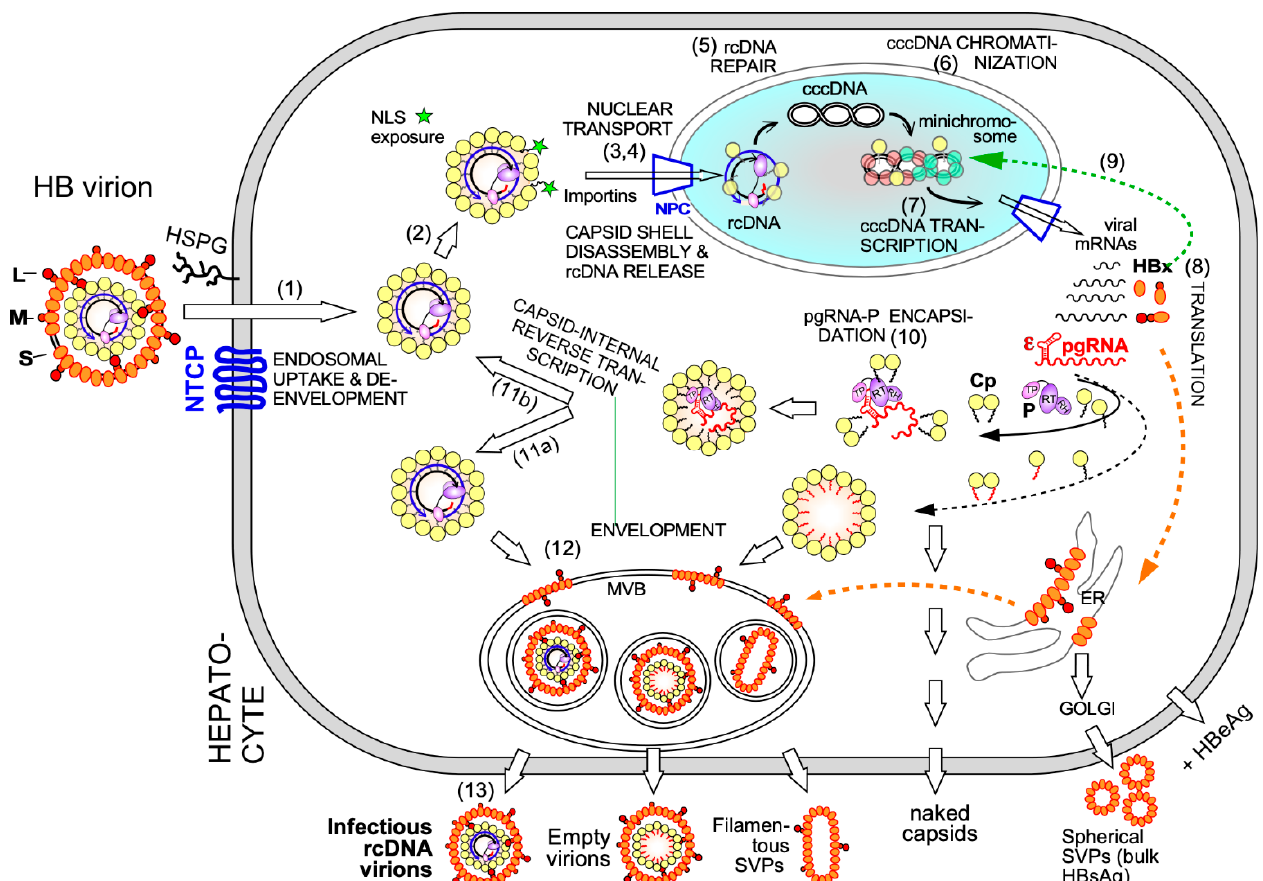
Figure 2. The HBV infectious cycle. The virion binds to heparan sulfate proteoglycans (HSPG) and via a high-affinity interaction of the L protein’s PreS1 domain to the hepatocyte-specific bile acid transporter NTCP, triggering entry into the cell. The subsequent steps leading to production of infectious progeny virions are numbered. (1) Endosomal uptake and loss of the envelope; (2) exposure of NLSs to importins; (3) nuclear transport and capsid shell disassembly at the nuclear pore complex (NPC); (4) release of the rcDNA genome into the nucleus; (5) repair to cccDNA; (6) minichromosome formation; (7) transcription by RNA polymerase II; (8) translation of viral proteins, including HBx; (9) stimulation of cccDNA transcription by HBx; (10) packaging of the pgRNA-P protein complex into newly forming nucleocapsids; (11) capsid-internal reverse transcription of pgRNA into new rcDNA; via (11a) to (12) envelopment of mature rcDNA containing nucleocapsids and (13) egress from the cell via the multivesicular body (MVB) compartment; or via (11b) recycling of rcDNA (2) to the nucleus to replenish the cccDNA pool. Infected cells also release empty virions, i.e., enveloped empty capsids and small amounts of enveloped RNA containing capsids (not shown). Further viral particles include non-enveloped “naked” capsids, and spherical and filamentous subviral particles (SVPs) comprising only envelope proteins. Secreted nonparticulate HBeAg arises from processing of the precore protein (not shown).